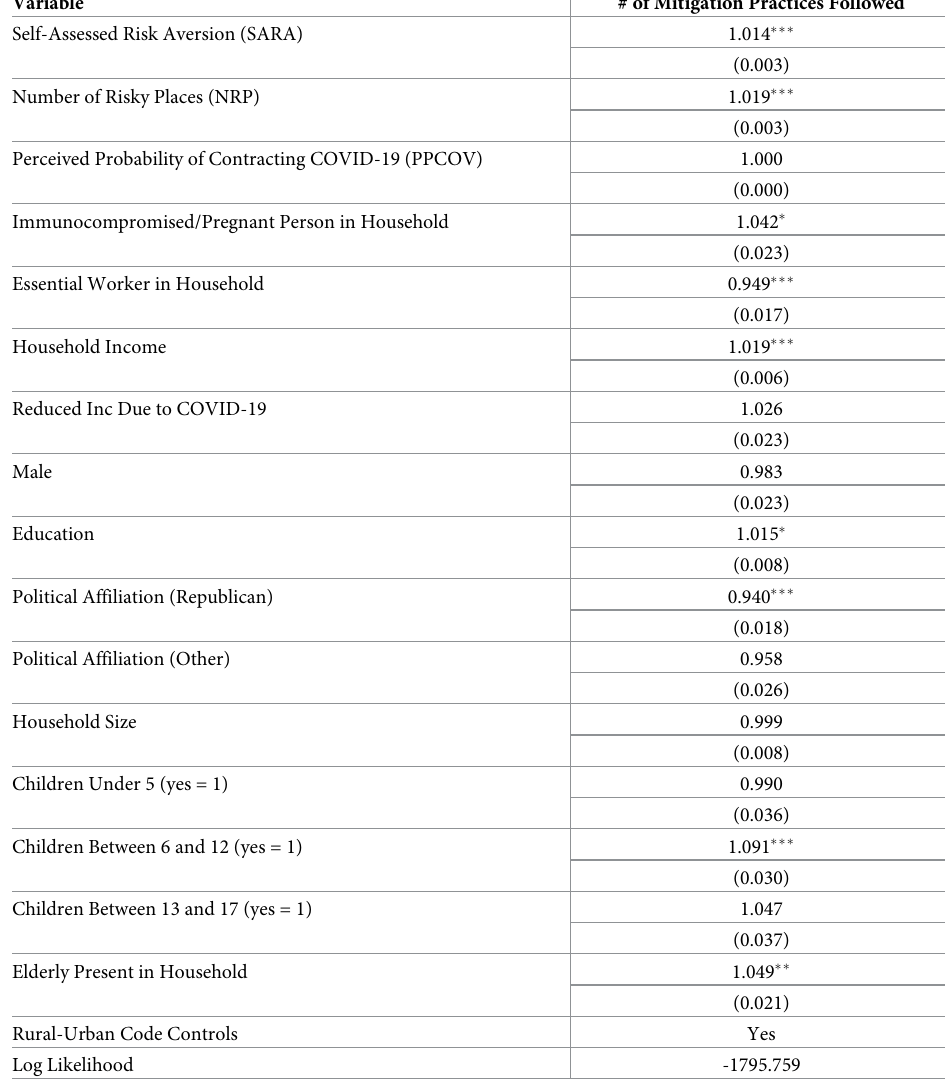
Table 5. Odds ratios for factors correlated with the number of mitigation practices